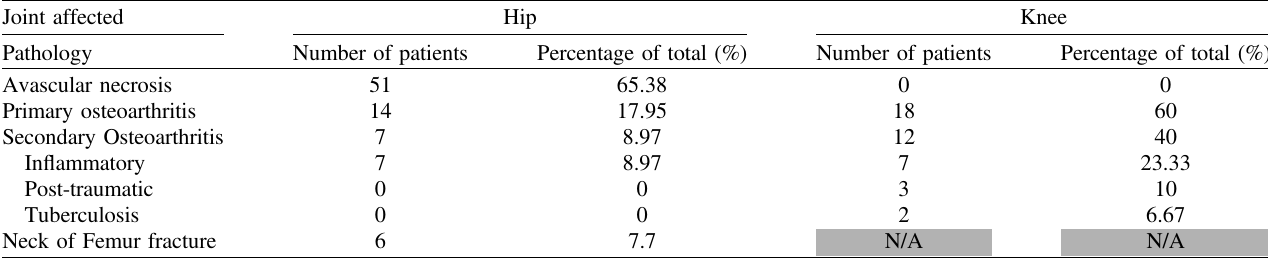
Table 3. Pathology of seropositive patients for total joint